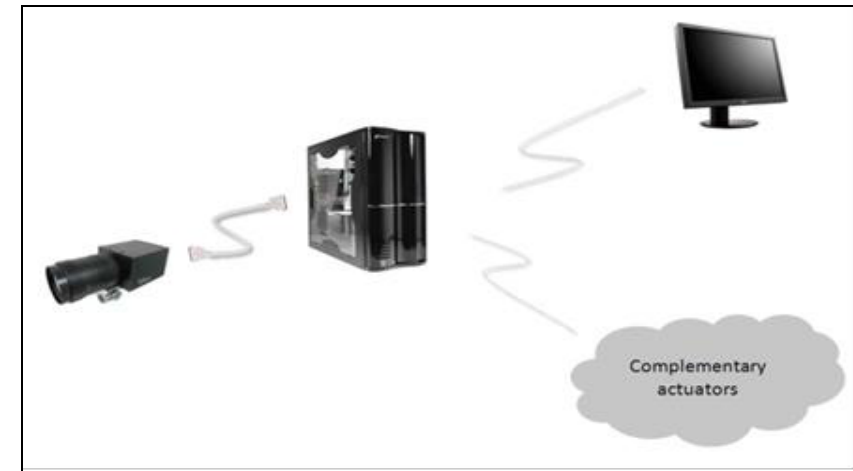
Figure 1: Traditional computer vision